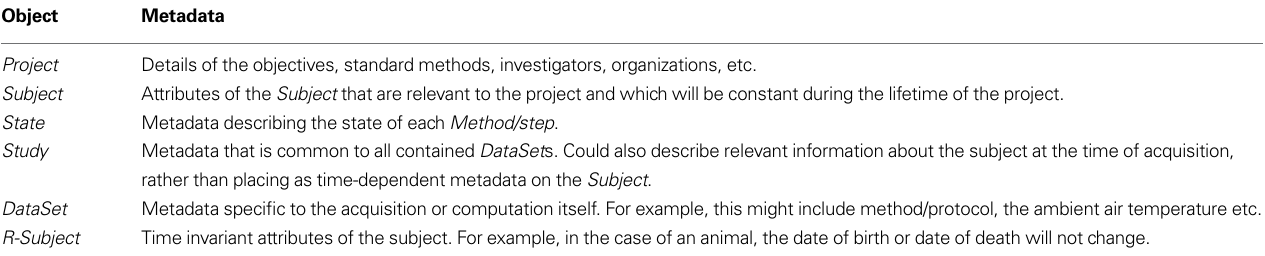
Table 3 | Placement of domain-specifi c metadata on Framework objects. Object